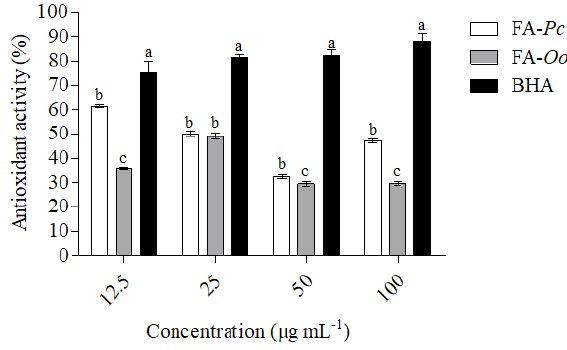
Figure 5 - β -carotene bleaching (BCB) of fatty acids (FA) present in the hexane extract from marine red algae Pterocladiella capillacea ( Pc ) and Osmundaria obtusiloba ( Oo ).